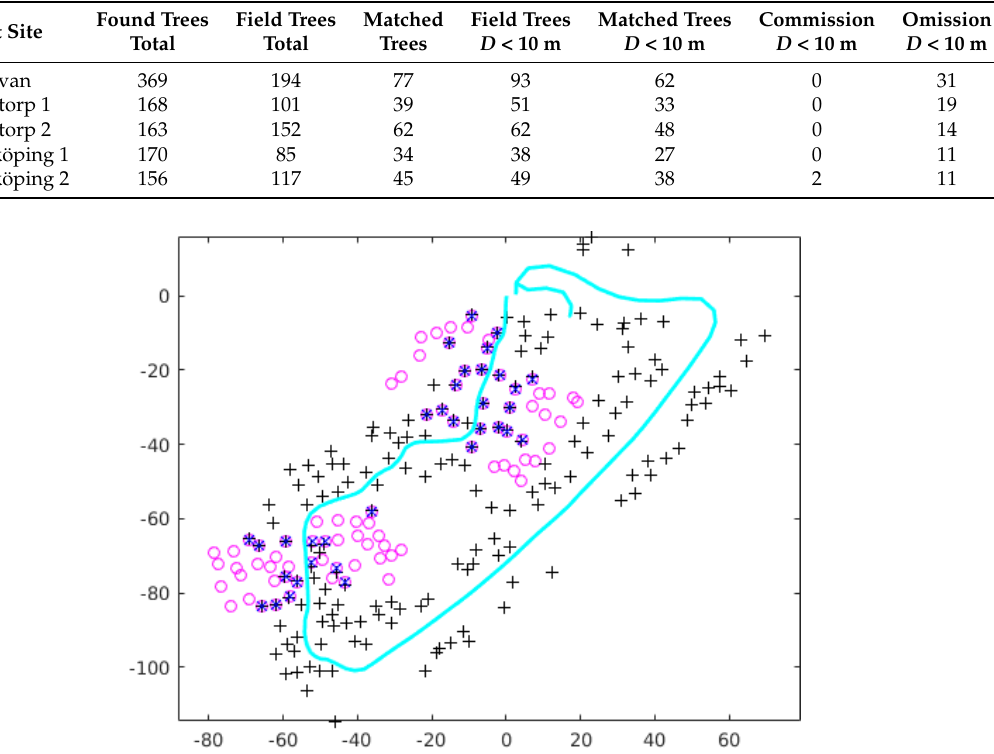
Figure 17. Malmköping 1. Map over detected trees (black ‘+’), field measured trees (magenta ‘o’) and linked trees (black ‘+’ + magenta ‘o’ + blue ‘x’). The cyan line shows the vehicle trajectory, starting in [ 0,0 ] .